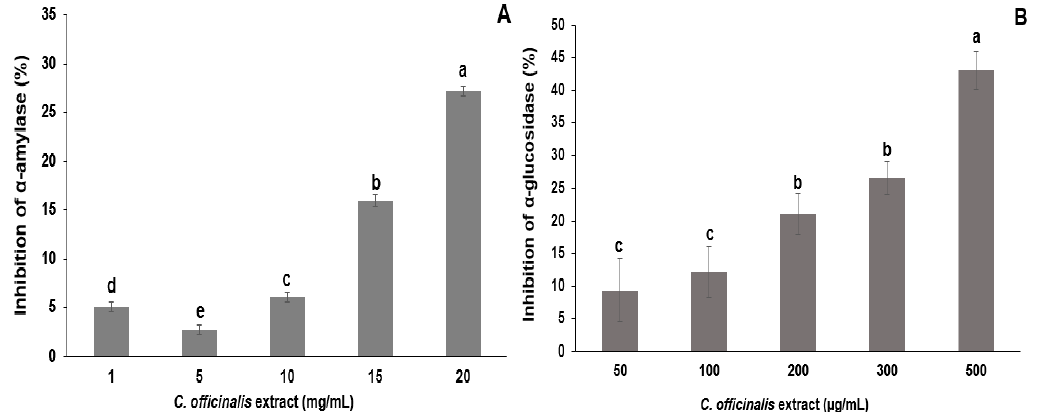
Figure 4. In vitro inhibitory effects of different concentrations of lyophilized marigold extract ( C. officinalis ) on the activities of α -amylase ( A ) and α -glucosidase ( B ) enzymes. Different letters (a–e) represent statistically significant differences ( p < 0.0001).